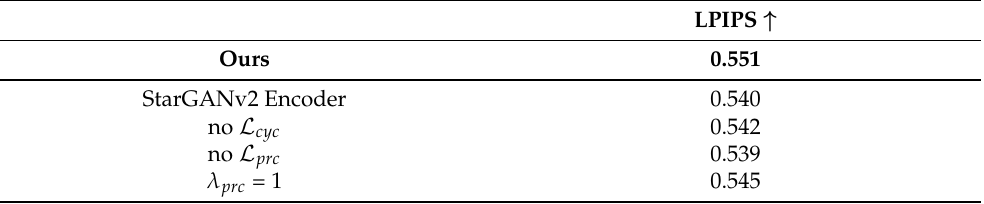
Table 3. Quantitive comparison between results with StarGANv2 and with our